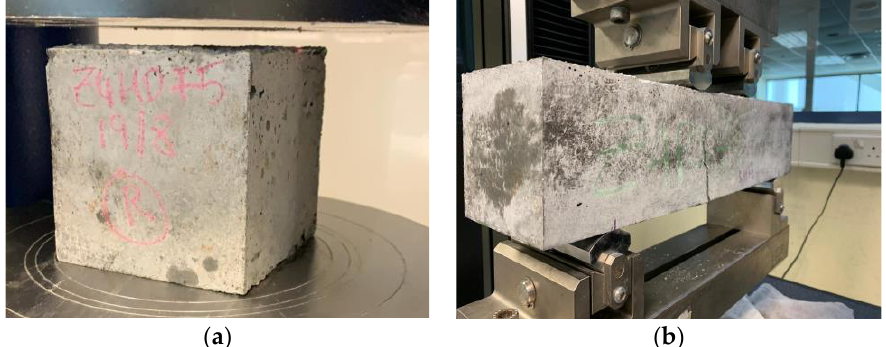
Figure 4. Mechanical test setup: ( a ) compressive strength and ( b ) flexural strength.